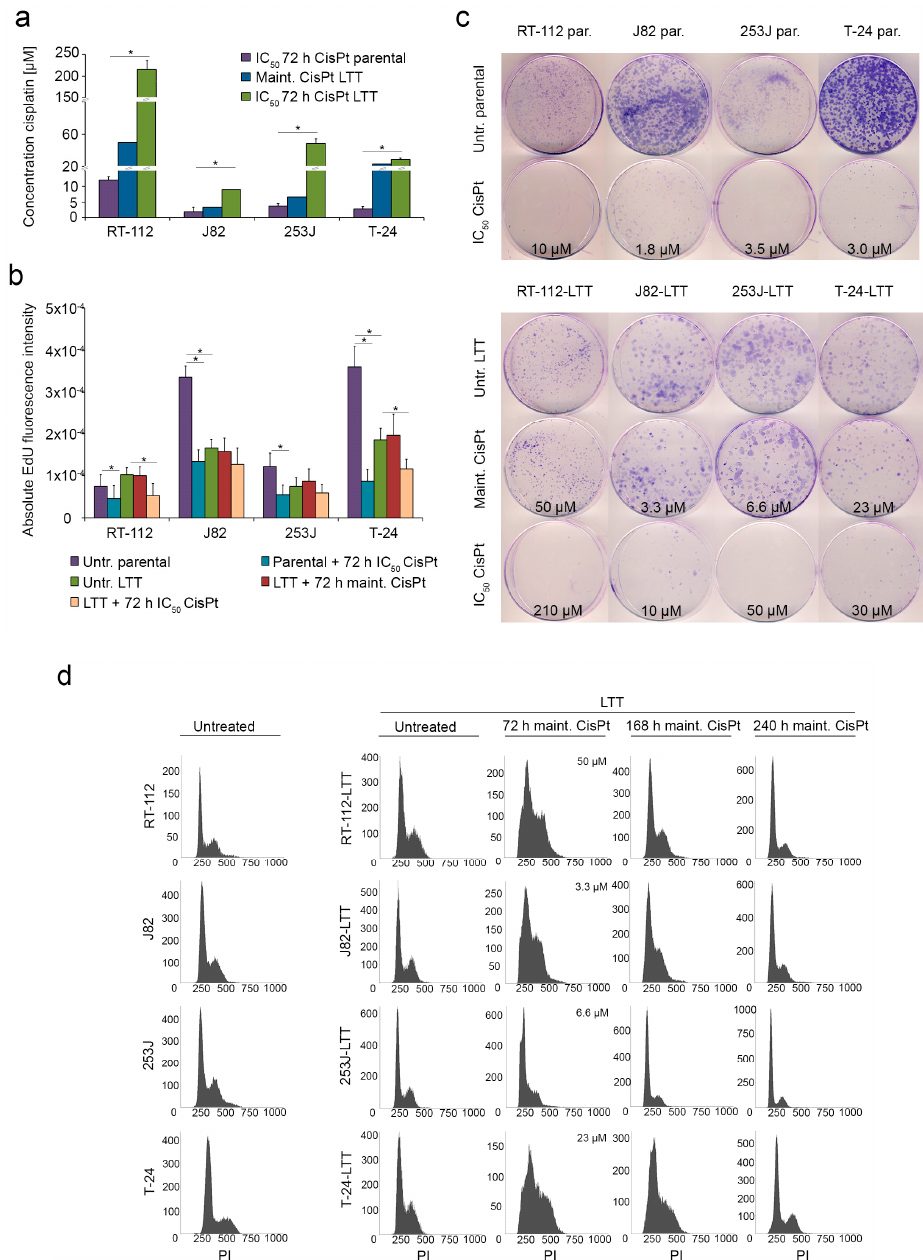
Figure 1. Long-term cisplatin treated cells (LTTs) recover from cisplatin-induced stress. ( a ) Cell viability was measured in treatment-naive parental urothelial carcinoma cell lines (UCCs) and resistant LTTs 72 h after treatment with indicated doses of cisplatin by MTT assay. Maintenance cisplatin concentration of LTTs is shown for comparison; ( b ) Proliferation of parental cells and LTTs treated with either IC 50 or maintenance concentrations of cisplatin for 72 h as measured by EdU incorporation assay; ( c ) Colony formation assay of parental cells and LTTs treated with either IC 50 or maintenance concentrations of cisplatin for 72 h. Cell clones were stained by Giemsa; ( d ) Changes in cell-cycle distribution and amount of apoptotic cells (as sub-G1 fraction) in untreated LTTs and 72, 168, and 240 h after maintenance cisplatin treatment measured by flow cytometry. Untreated parental UCCs served as a control (left panel). Values represent the mean ± standard deviation (SD) of two independent experiments. * p < 0.05.